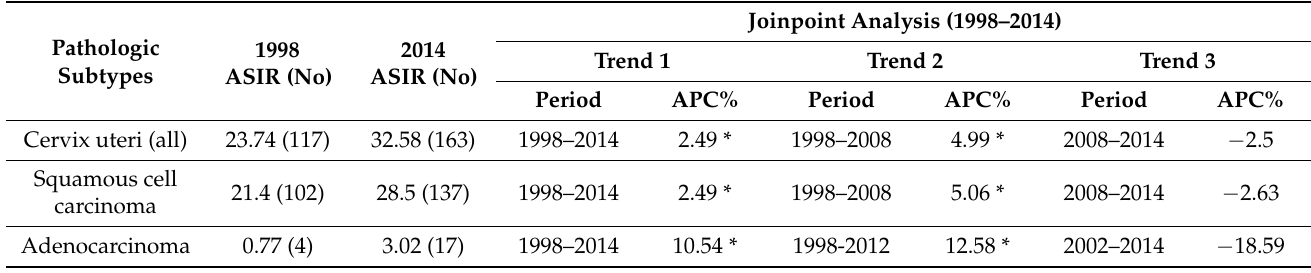
Table 2. Time trends of age-standardized incidence rates (ASIR) (cases/100,000) of cervical cancer, Cluj County, 1998–2014.